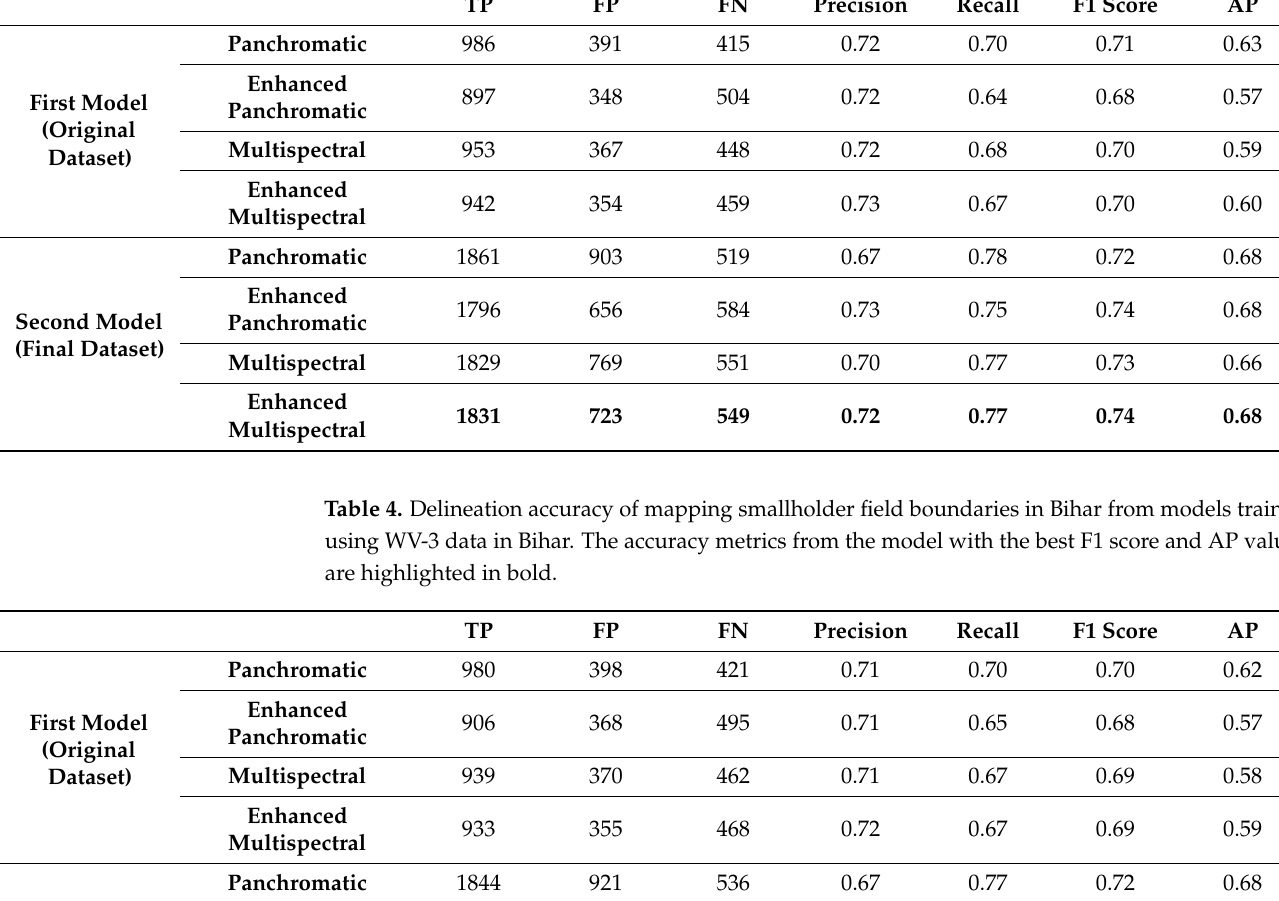
Table 3. Detection accuracy of mapping smallholder field boundaries in Bihar from models trained using WV-3 data in Bihar. The accuracy metrics from the model with the best F1 score and AP values are highlighted in bold. TP FP